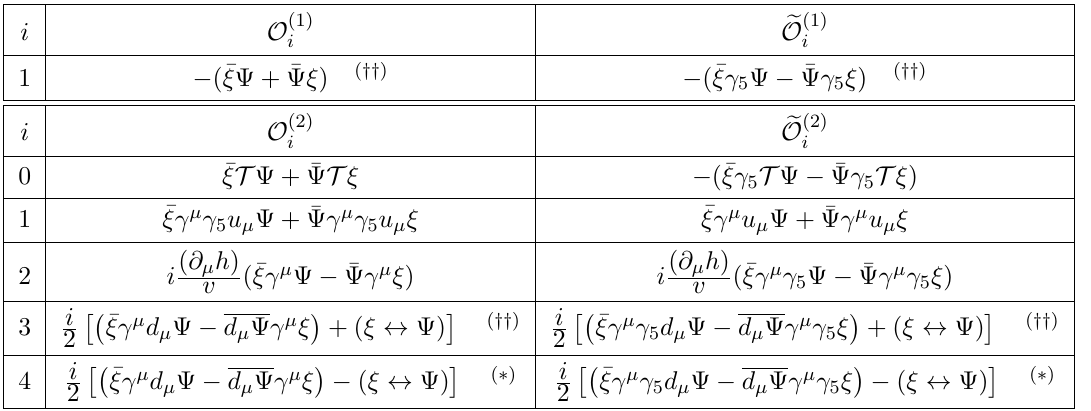
Table 12 . CP -conserving operators of O ( p 1 ) and O ( p 2 ) with one heavy resonance and one light fermion (cid:12)eld. O i ( e O i ) denote P -even (odd) structures. Terms that can be rotated away through the diagonalization of the \kinetic" and \mass" terms are marked with ( yy ). Terms marked with ( (cid:3) ) are